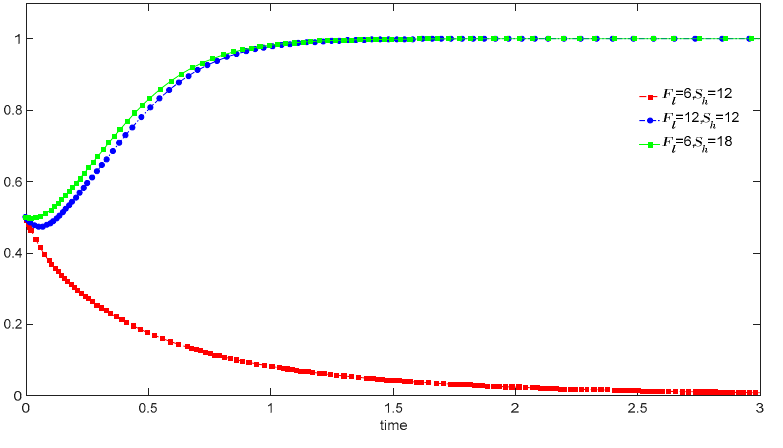
Figure 13. The sensitivity of subsidies and penalties for producer.